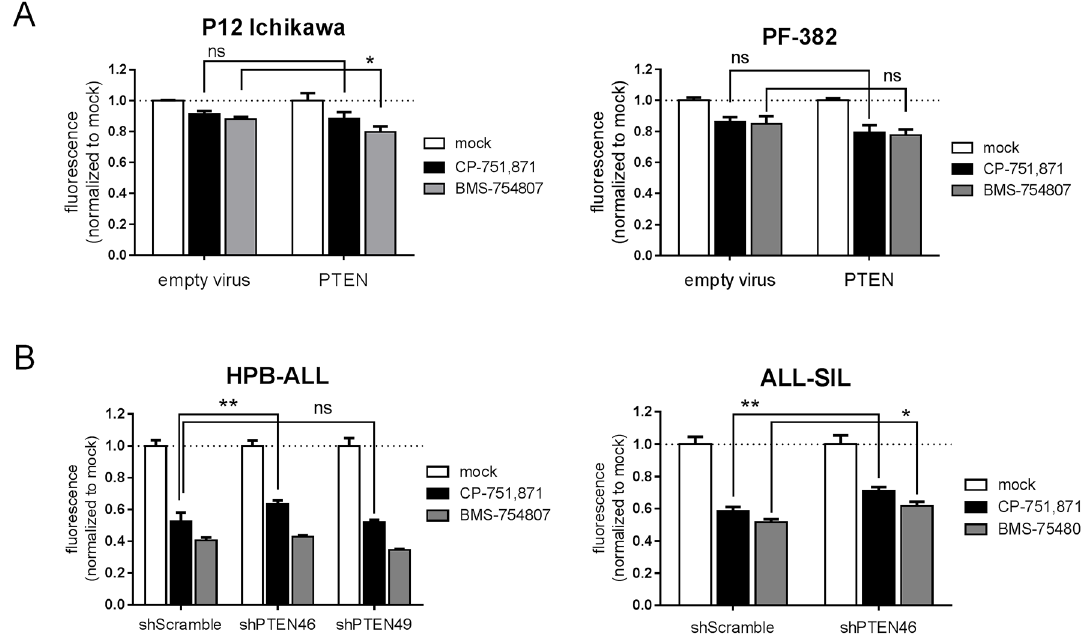
Fig 5. PTEN contributes to, but does not define IGF dependence. Cell growth as measured by resazurin reduction assay. ( A ) PTEN-negative cell lines (P12 Ichikawa and PF-382) or ( B ) PTEN-positive cell lines (HPB-ALL and ALL-SIL) were transduced with lentiviral PTEN expression or knock-down constructs, respectively, FACS sorted, and then cultured in vitro with IGF1R blocking antibody (1 μ g/ml CP-751,871) or dual IGF1R/InsR tyrosine kinase inhibitor (0.5 μ M BMS-754807) for 2 – 3 days. Mean resorufin fluorescence values +/- SD after normalization to respective mock-treated controls are plotted for assays performed in triplicate. * , p < 0 . 05; ** , p < 0 . 01; ns , not significant (2-way ANOVA with Sidak ’ s multiple comparisons test